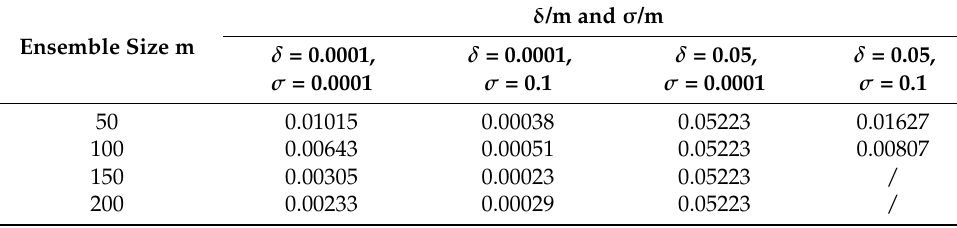
Table 4. RMSE values with different ensemble sizes at fixed δ and σ values for Station